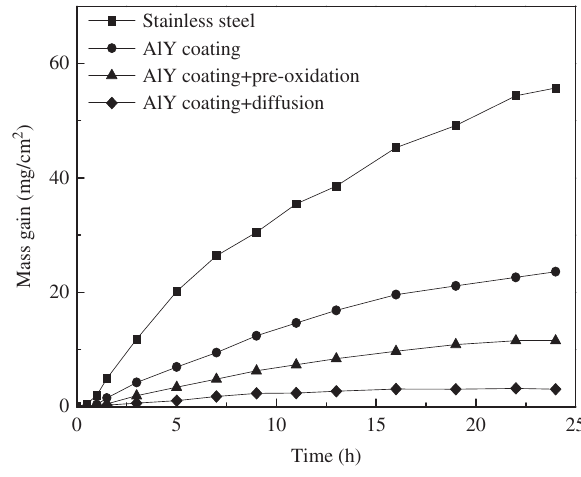
Figure 4: The oxidation kinetic curves of different specimens.